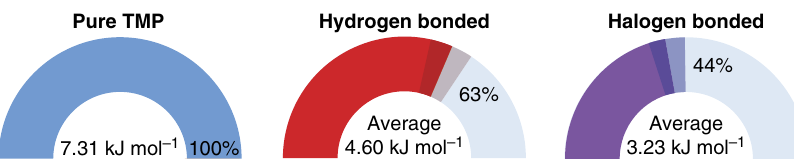
Fig. 6 Summary of the reduction in the experimentally measured activation energy associated with the rotation of the methyl groups. The average activation energies are given for the halogen bonded and hydrogen bonded